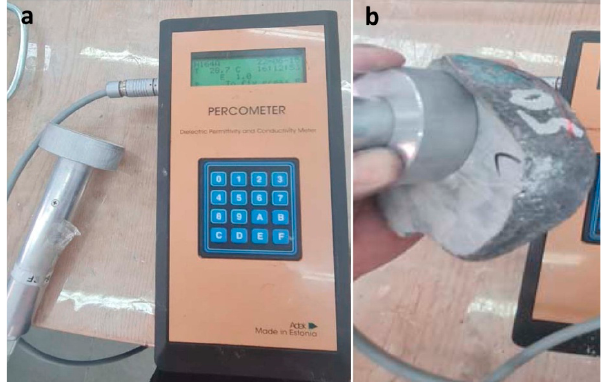
Figure 10. ( a ) The assemblage of chert sample and two ultrasonic sensors; ( b ) the typical shape of transmitted (yellow) and received (blue) ultrasonic pulses.